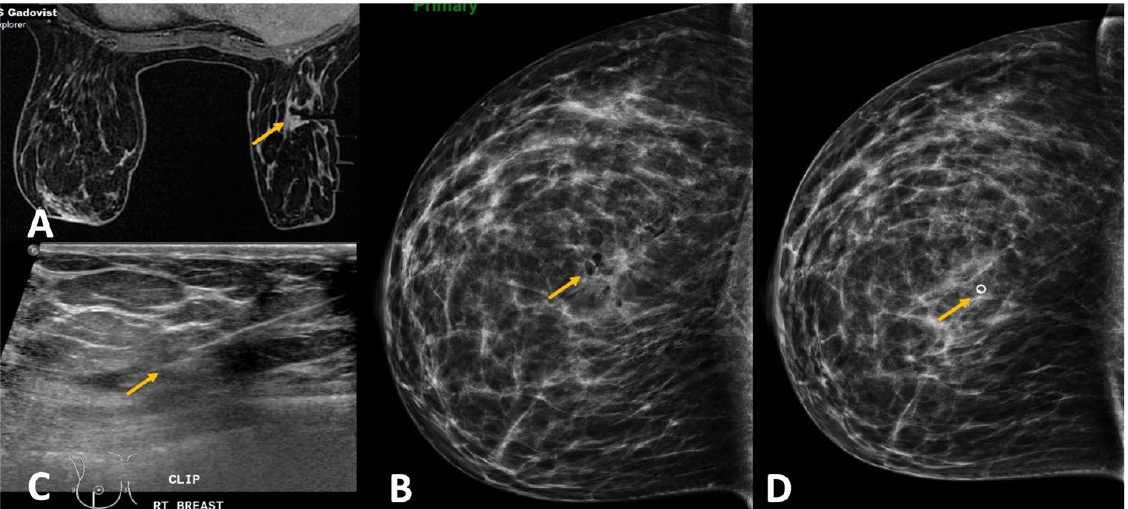
Figure 11. ( A ). MRI-guided biopsy of right breast for a 7 mm suspicious mass (yellow arrow) was performed to rule out synchronous cancer. The procedure was uneventful. ( B ). Post-biopsy check mammogram showed absent marker clip and air within the biopsy cavity (yellow arrow). An